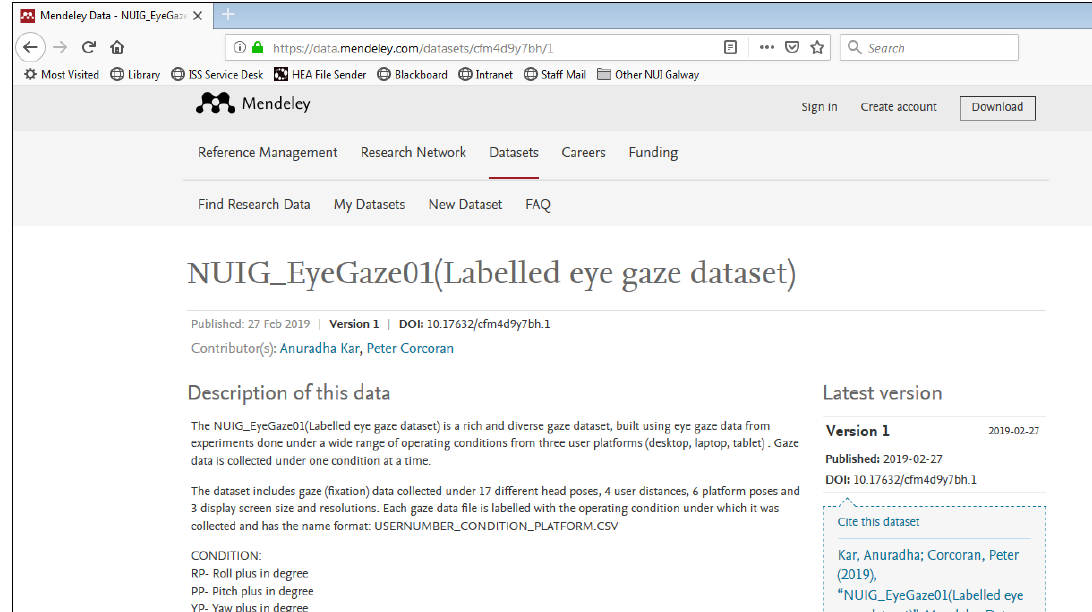
Figure 15. Dataset organization in the NUIG_EyeGaze01 repository on Mendeley data.